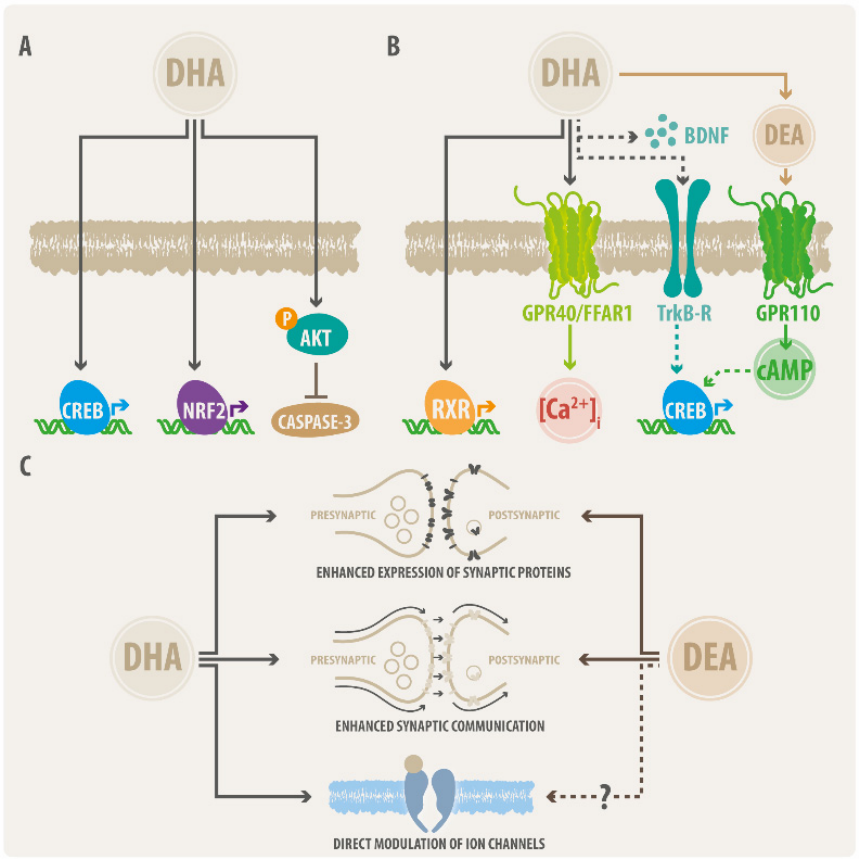
Figure 2. DHA signaling pathways in neuron survival, morphology, and synaptic function. ( A ) DHA can promote neuron survival by different mechanisms, including the induction of cAMP response element-binding (CREB) and nuclear factor erythroid 2-related factor 2 (NRF2) pathways, or apoptosis inhibition by reducing the activities of caspase-3 and caspase-8. ( B ) Regarding neural morphology, DHA can trigger the activation of retinoid X receptor (RXR) and the G-protein coupled receptor GPR40/FFAR1, which can increase intracellular calcium by activation of Gq/PLC/IP3 or by activation of the tyrosine kinase Trk-B receptor (Trk-B-R) by its activator, brain-derived neurotrophic factor (BDNF), with subsequent activation of the CREB pathway. This latter axis can also be activated by the DHA metabolite DEA (synaptomide), which induces a GPR110-mediated increase in cAMP levels. ( C ) The effects of DHA and DEA on synaptic function include the expression of synaptic proteins, such as postsynaptic receptors or scaffolding proteins (left scheme), which lead to an enhancement of synaptic communication (middle scheme). Additionally, DHA exert a direct effect on ion channels, modulating their gating properties (right scheme). Whether DEA is also able to modulate the activity of ion channels is